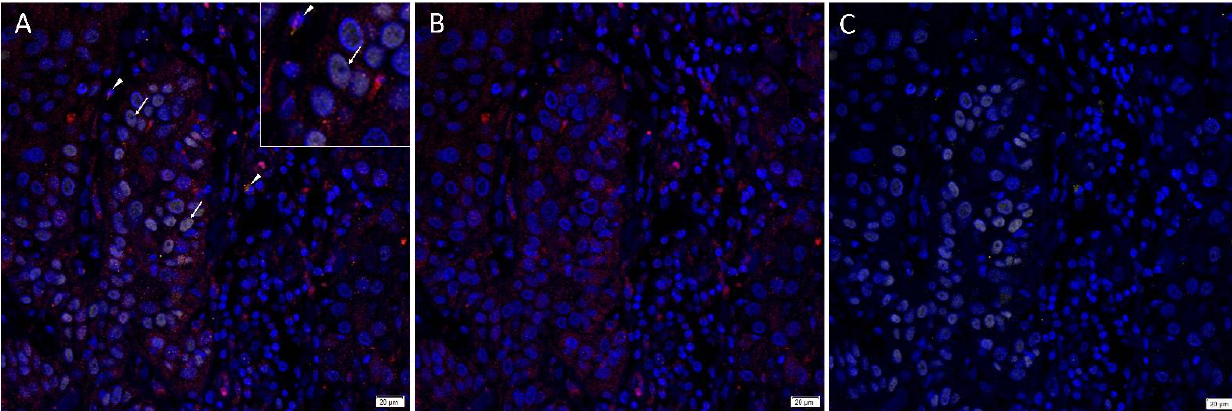
Figure 3. Representative merged and split immunofluorescence-stained sections of metastatic head and neck cutaneous squamous cell carcinoma demonstrating the expression of PRR ( A , B , red) by SOX2+ ( A , C , yellow) CSCs throughout the tumor nests (TNs, arrows ) and the peritumoral stroma (PTS, arrowheads ). Cell nuclei were counter-stained with 4 (cid:48) ,6- diamidino-2-phenylindole ( A – C , blue). The inserts show enlarged views of the corresponding images Original magnification 400 × . n =